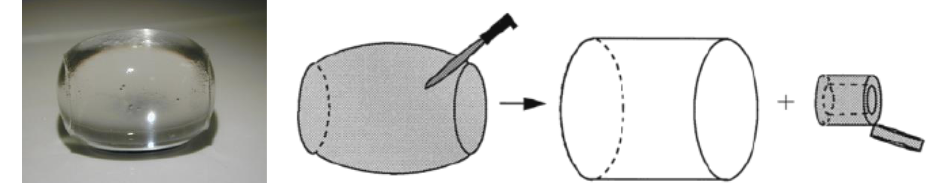
Figure 11. Illustration of the removal of the shell from the core of a PA–C 16 TABr gel ( 𝛽 = 0.5). Photograph to the left shows the intact gel. Figures taken from ref. [21]. Adapted with permission from J. Phys. Chem. B 2002, 106, 9777-9793. Copyright 2002 American Chemical Society.